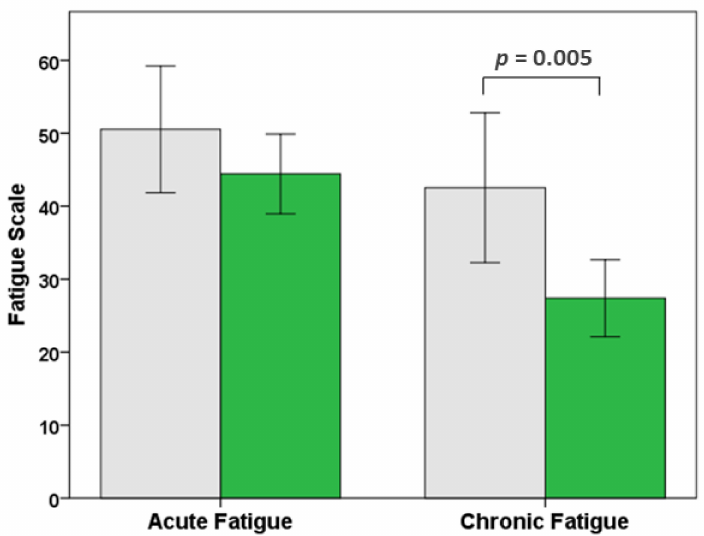
Figure 1. Acute fatigue and chronic fatigue pre-Covid-19. Drivers who visited nature at least once a week (green bars) had significantly lower chronic fatigue than those who did not (grey bars). 95% confidence